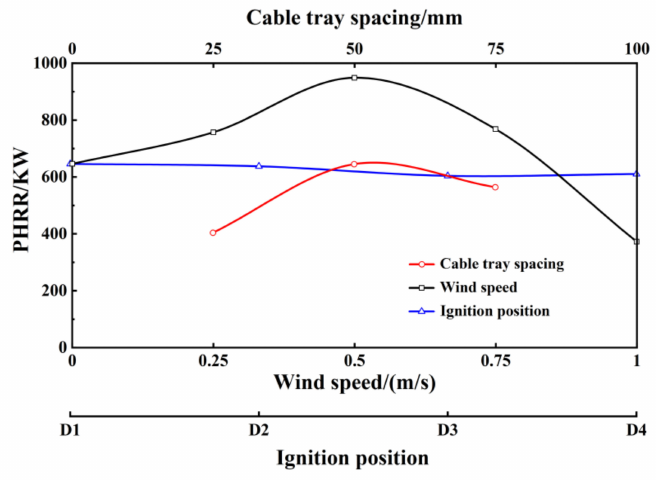
Figure 10. PHRR change curves under different working